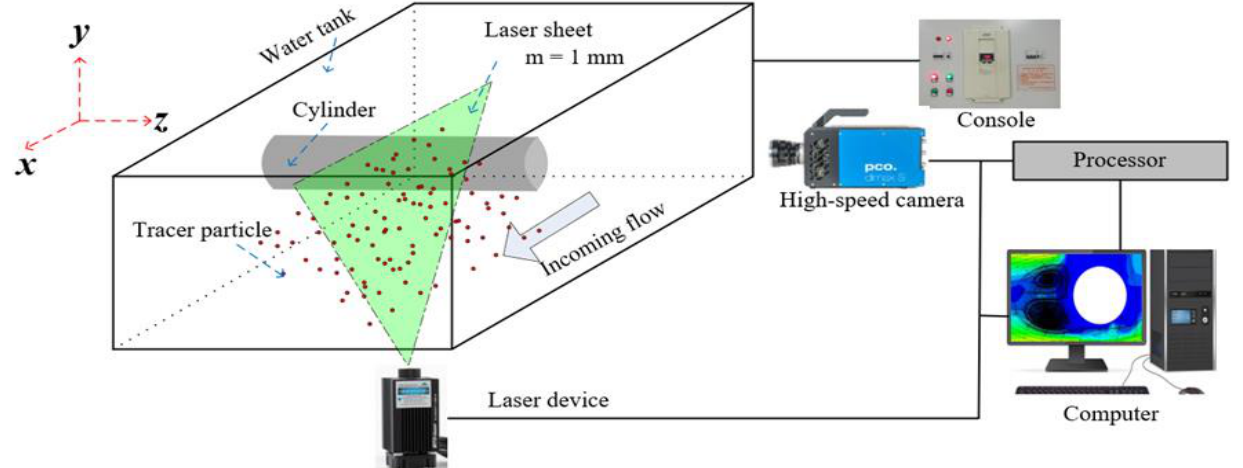
Figure 7. Experimental setup in the water tank.